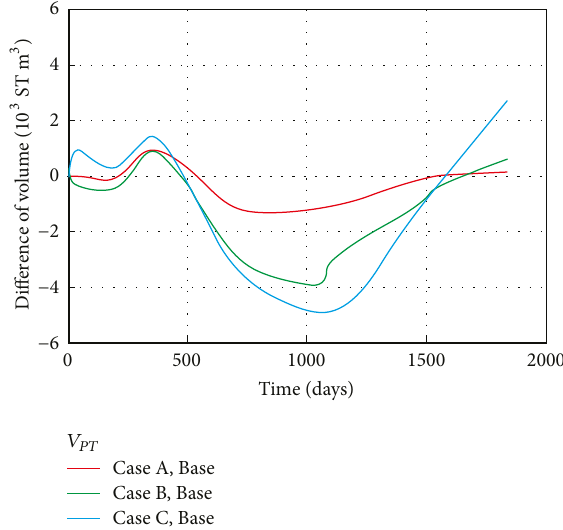
Figure 10: The difference of the cumulative volume of methane gas produced at the well ( 𝑉 𝑃𝐺 ) and the dissolved methane produced at the well ( 𝑉 𝑃𝐴 ) between horizontal strata and those sloping formations over 5-year production period.